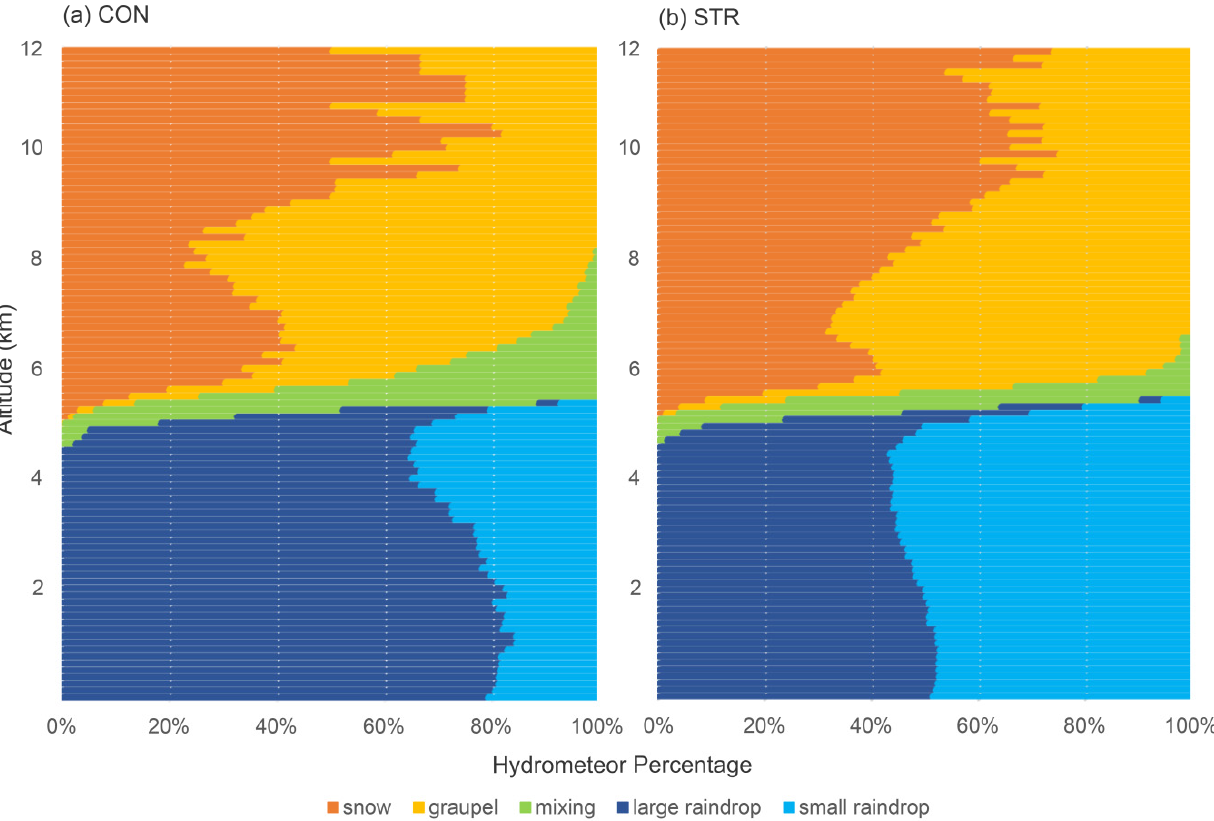
Figure 11. Variations of hydrometeor percentage with altitude in the ( a ) convective rain and ( b ) stratiform rain of Typhoon In-Fa (2021). Hydrometeor percentage represents the proportion of the amount of each type of hydrometeor to the total amount of all hydrometeor types. The hydrometeor types are identified based on GPM observation shown in Figure 2.